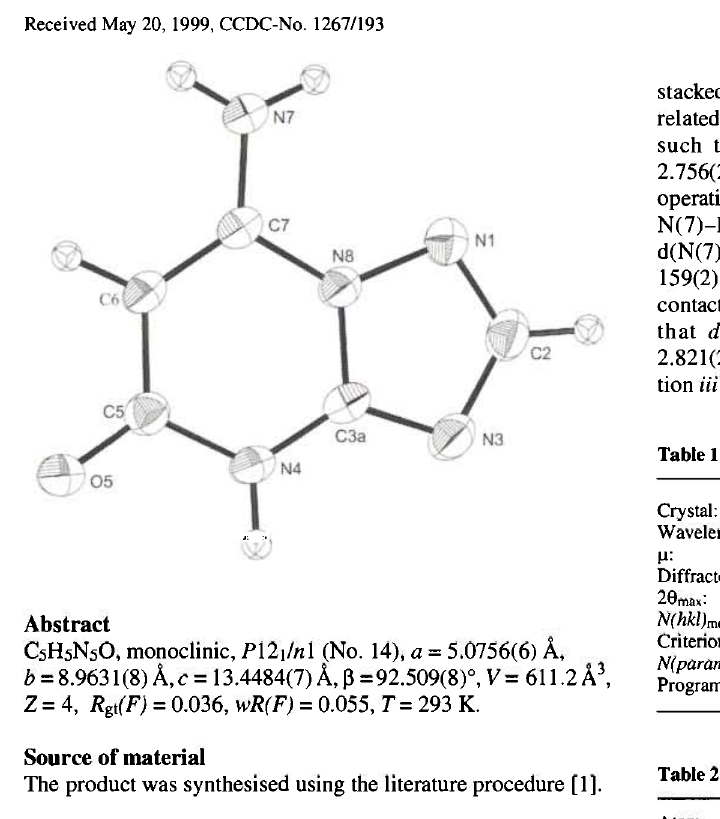
Table 2. Atomic coordinates and displacement parameters (in Ä 2